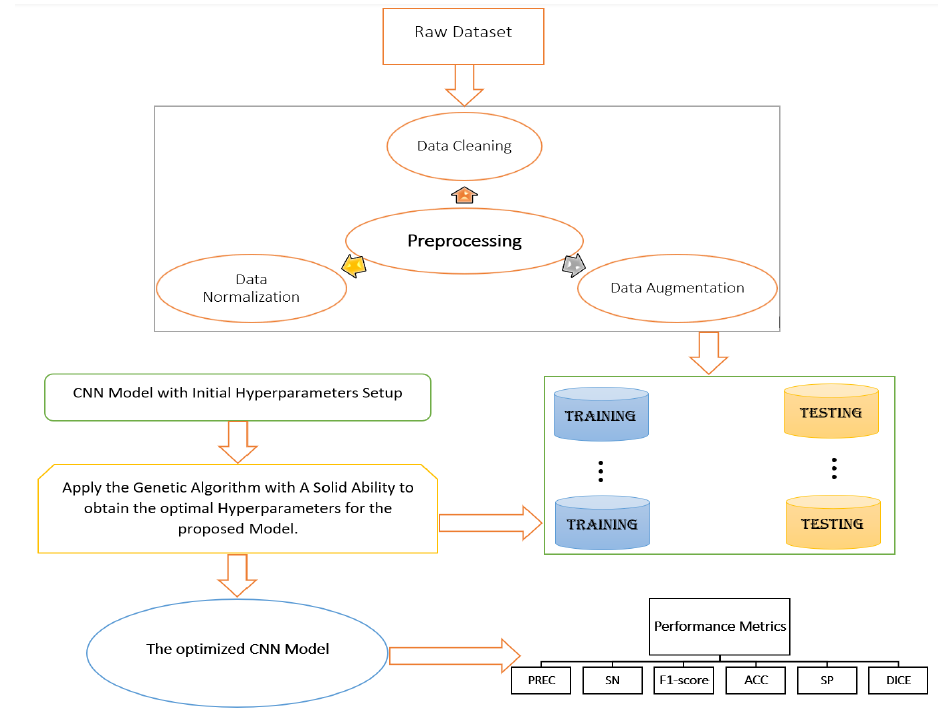
Figure 1. Methodology